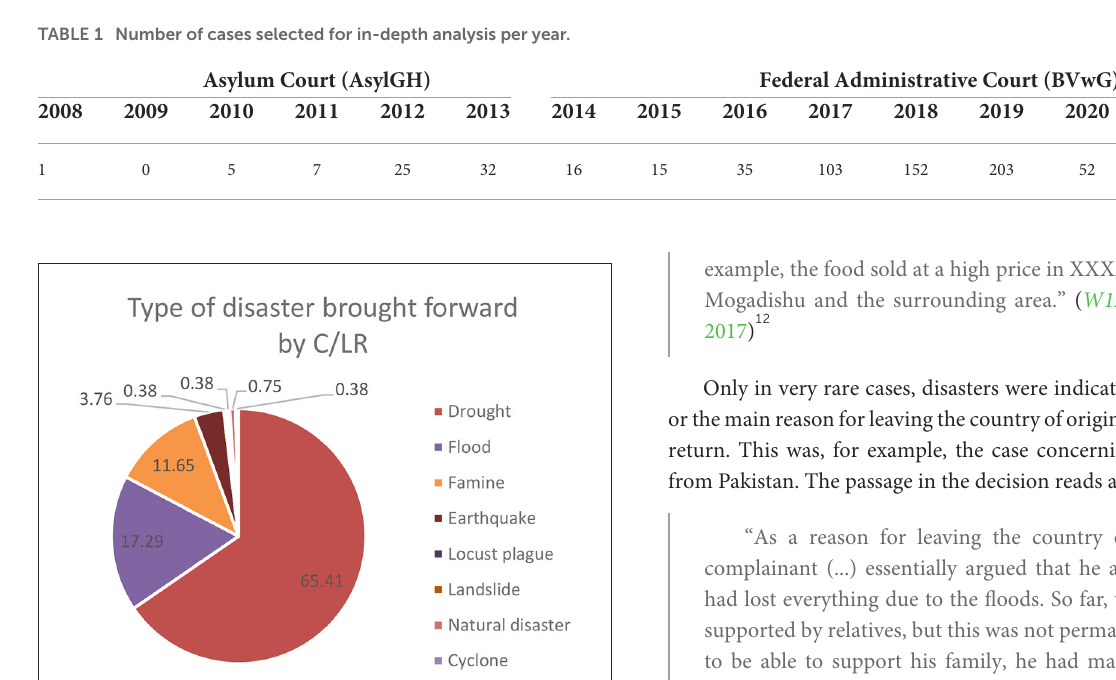
FIGURE4 Type of disaster brought forward by